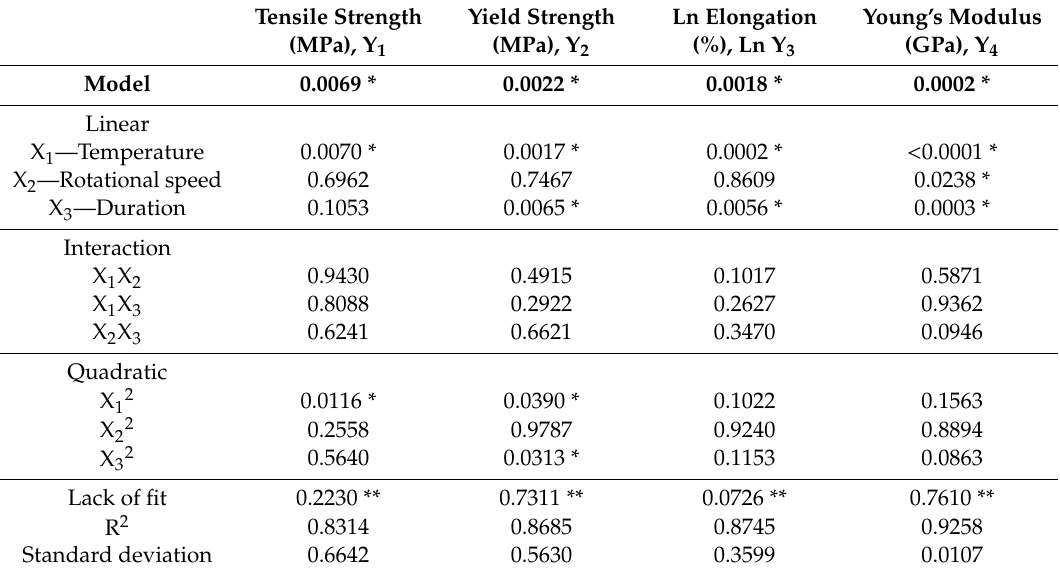
Table 2. Analysis of variance (ANOVA) for response surface quadratic